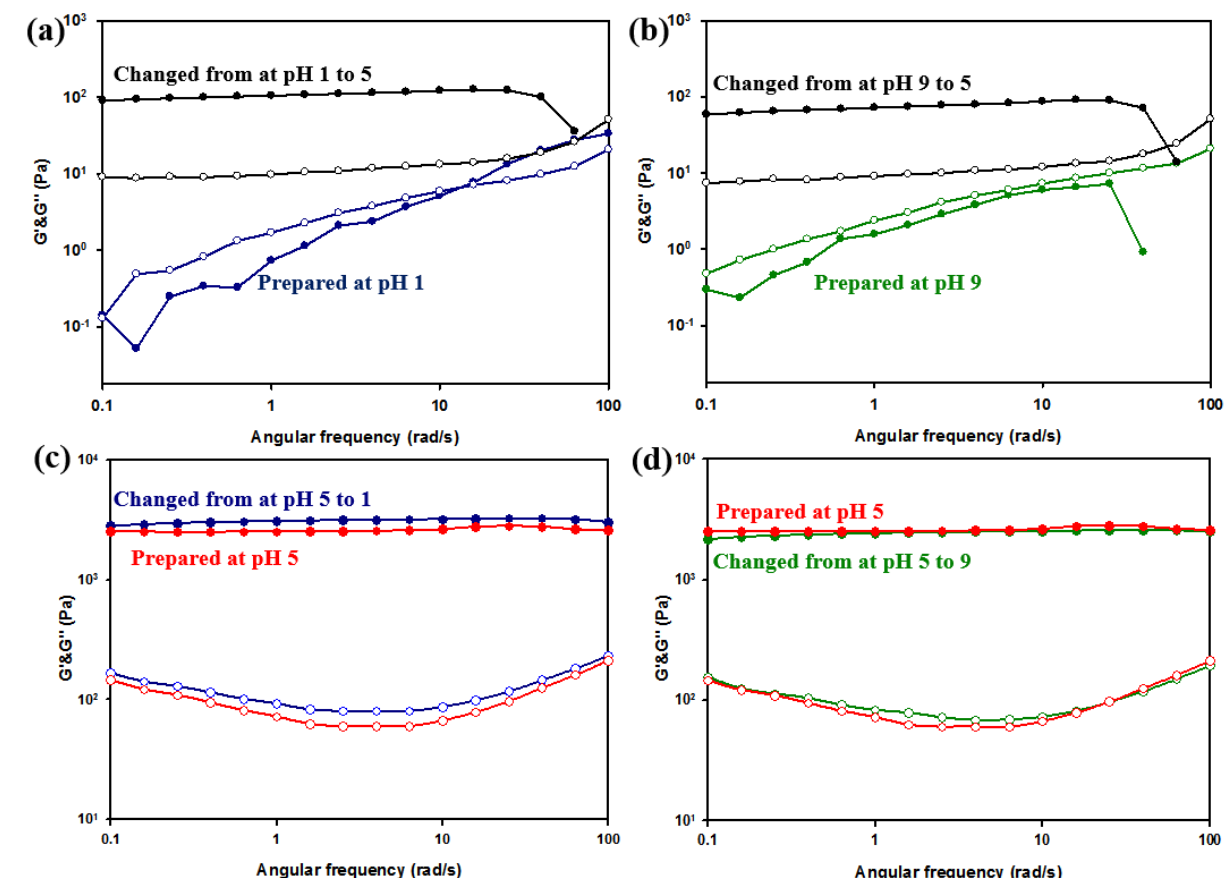
Figure 11. Gelation effect and mechanical properties of SC 26.4 based on pH changes: ( a ) from pH 1 to 5, ( b ) from pH 9 to 5, ( c ) from pH 5 to 1, and ( d ) from pH 5 to 9. Storage modulus (G′, filled symbols) and loss modulus (G′′, empty symbols) of hydrogels were measured as a function of angular frequency (0.1–100 rad/s).